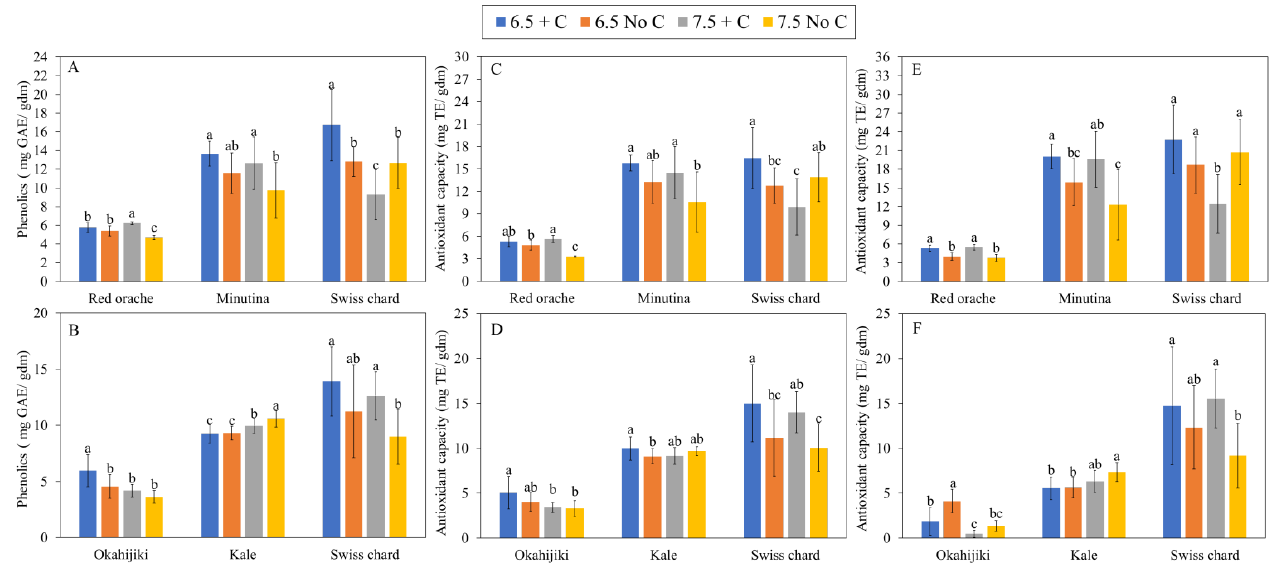
Figure 4. Total phenolic content of plants from first and second harvests are ( A ) and ( B ), respectively. Antioxidant capacity of plants from first and second harvests measured via ABTS and DPPH are ( C ) and ( D ), and ( E ) and ( F ), respectively. Different letters above the bars within plant species indicate significant difference based on Tukey’s honestly significant difference test (α = 0.05). Table 8. Two-way ANOVA of total phenolic content and antioxidant capacity (ABTS and DPPH) of plants from first and second harvests.